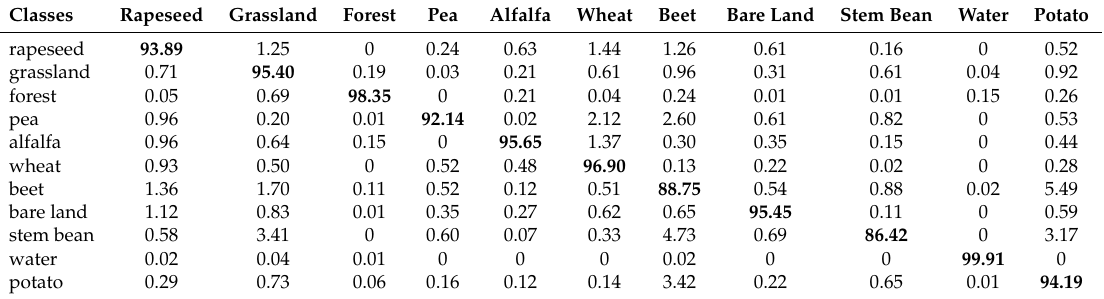
Table 5. Confusion matrix (%, category accuracy is shown in bold) of TSNE-FCN+SVM algorithm on Flevoland dataset.